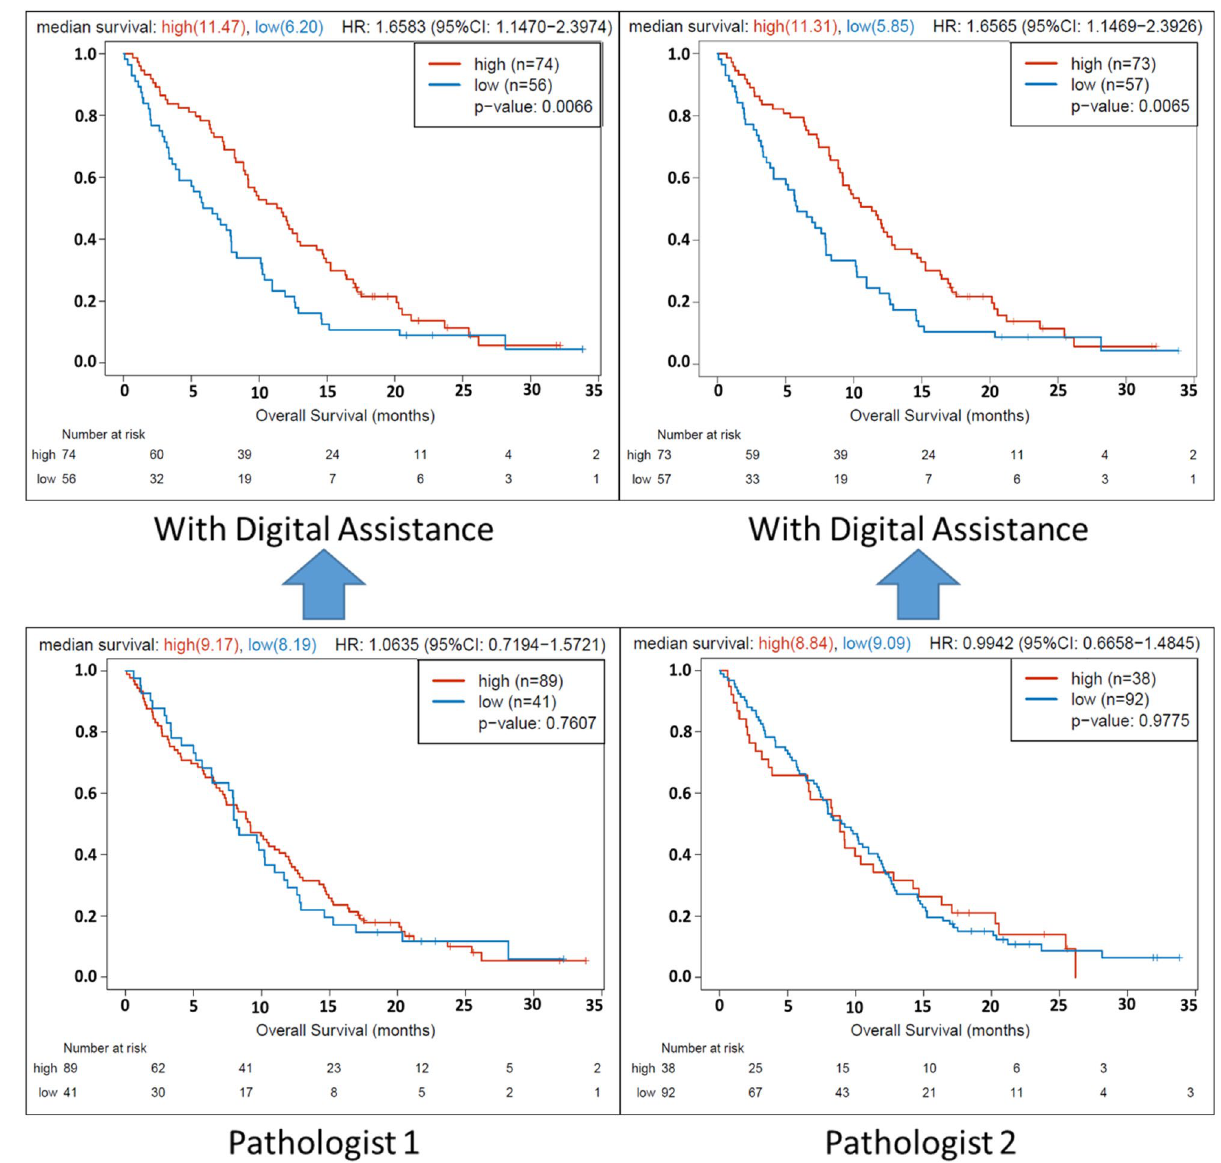
Figure 5. Digital assistance improves GATA6 IHC prediction of OS in advanced PDAC. Kaplan–Meier OS curves according to GATA6 IHC low and high expression assessed with computer assistance (top panels) and without computer assistance (bottom